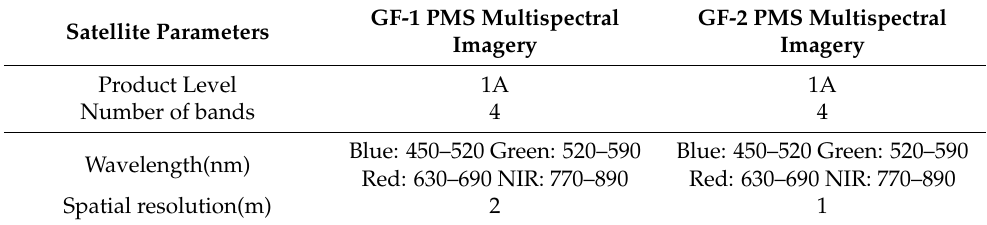
Table 1. Related information on reference